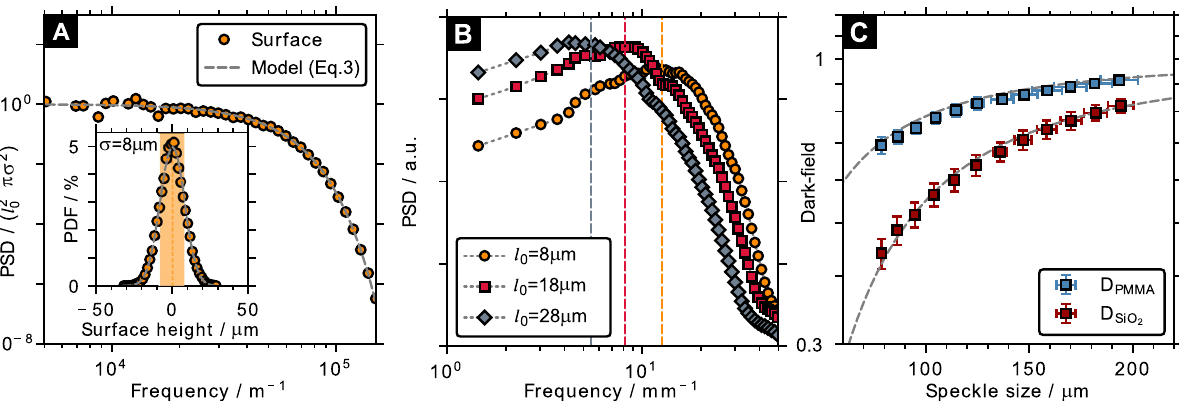
Figure 2. Influence of the speckle size on the dark-field signal. ( A ) Power spectral density (PSD) and probability density function (PDF) in comparison to the prescribed model of Eq. (3) for the surface structure of a single diffuser layer ( l 0 = 8 µ m , σ = 8 µ m ). ( B ) PSD of speckle patterns obtained for diffusers of different correlation lengths ( l 0 ) and the corresponding mean frequencies (dashed lines). ( C ) Theoretical dark-field ( D ) signals (dashed lines) as a function of speckle size ( p ) according to Eq. (5) and corresponding simulation results for a cubic sample containing an ensemble of glass (SiO 2 ) or PMMA spheres ( f = 0.05 , t = 5 mm and d = 4 µ m ) when using the mean frequency of the PSD as speckle